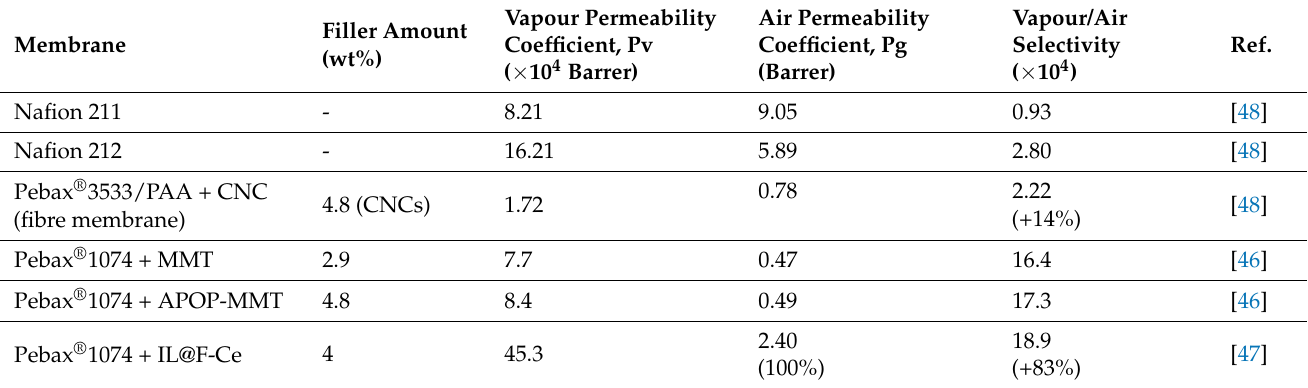
Table 8. Performance of Pebax-based MMMs as dehumidifiers for